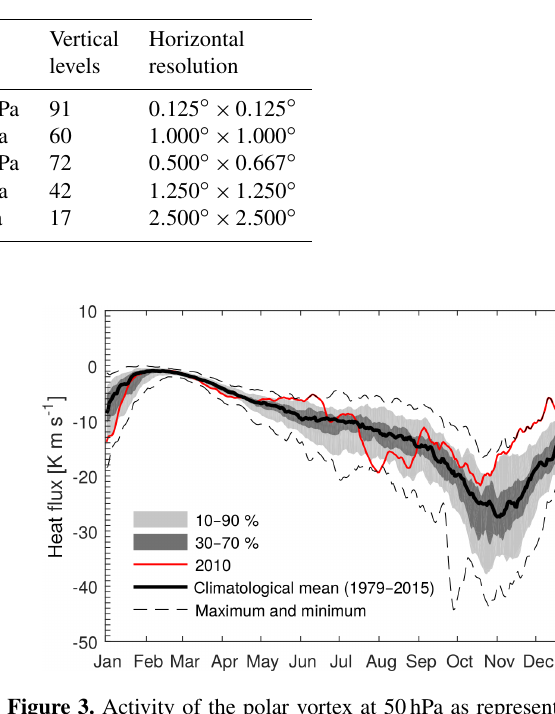
Figure 3. Activity of the polar vortex at 50hPa as represented by the 45-day running mean of the eddy heat flux between 45 and 75 ◦ S. The red curve shows results for the year 2010. Black and gray curves illustrate statistics of the long-term mean (1979–2015). This analysis was obtained from NASA Ozone Watch from their web site at https://ozonewatch.gsfc.nasa.gov (last access: 16 De- cember 2016) and is based on MERRA-2